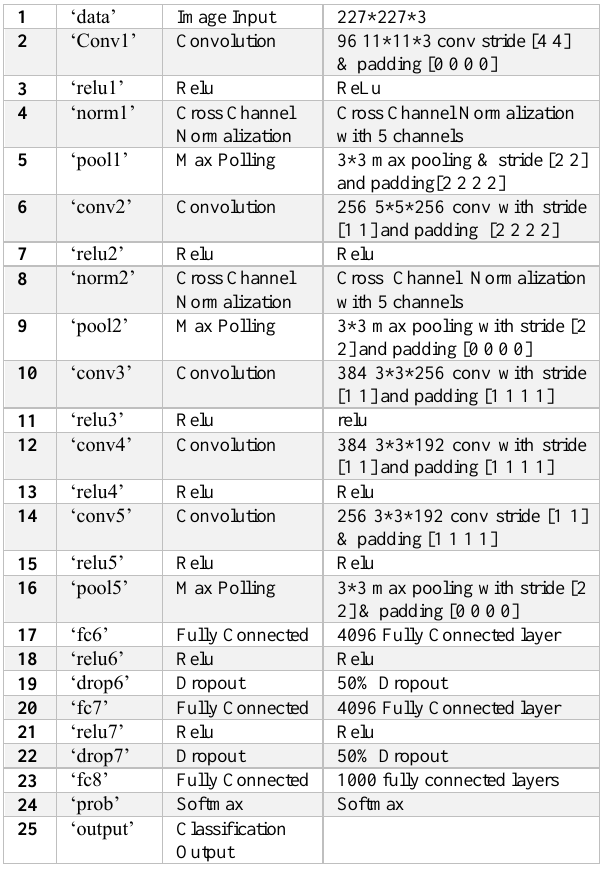
Table 1 Modified 25x1 Alexnet Architecture 1